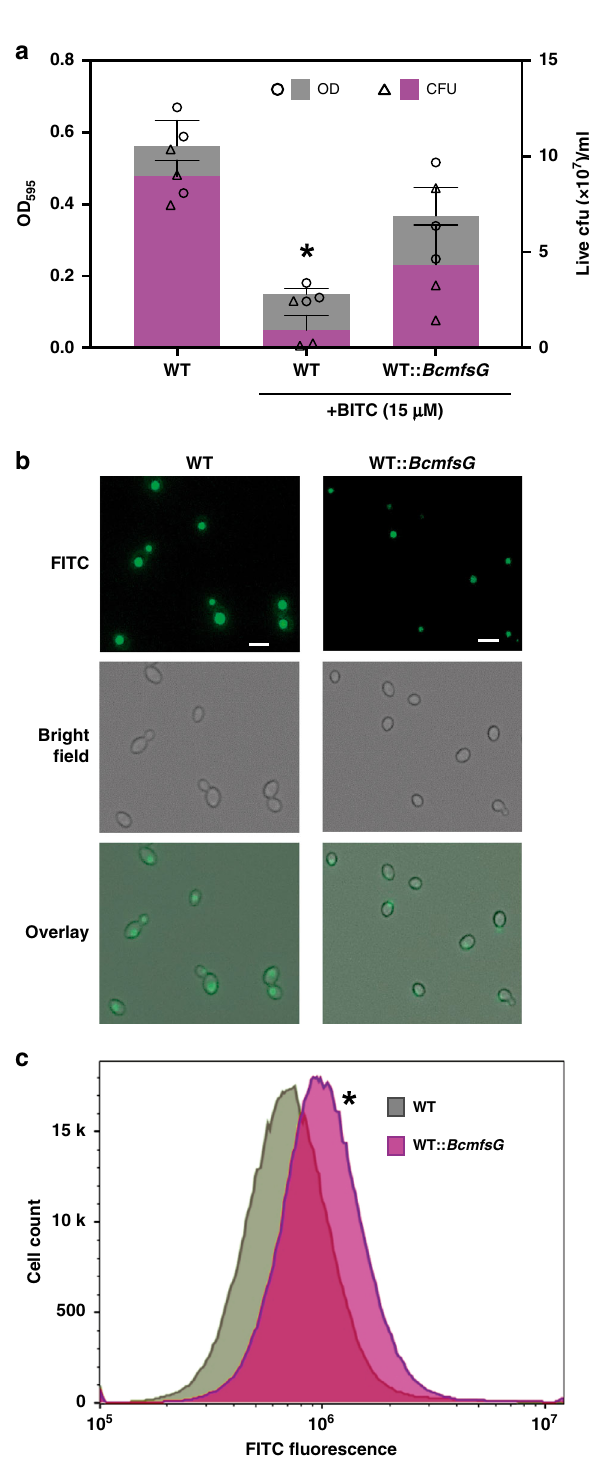
Fig. 6 Ectopic expression of B. cinerea mfsG and ef fl ux study in yeast. a Saccharomyces cerevisiae wild-type cells (WT), and cells expressing BcmfsG (WT:: BcmfsG ) were grown with or without 15 µ M BITC in liquid media. OD and live colony-forming units (cfu) were measured after 48 h. Data are displayed as mean values (± SE). Asterisk denotes signi fi cant difference by Student ’ s t test ( P < 0.001), n = 3. b S. cerevisiae WT and